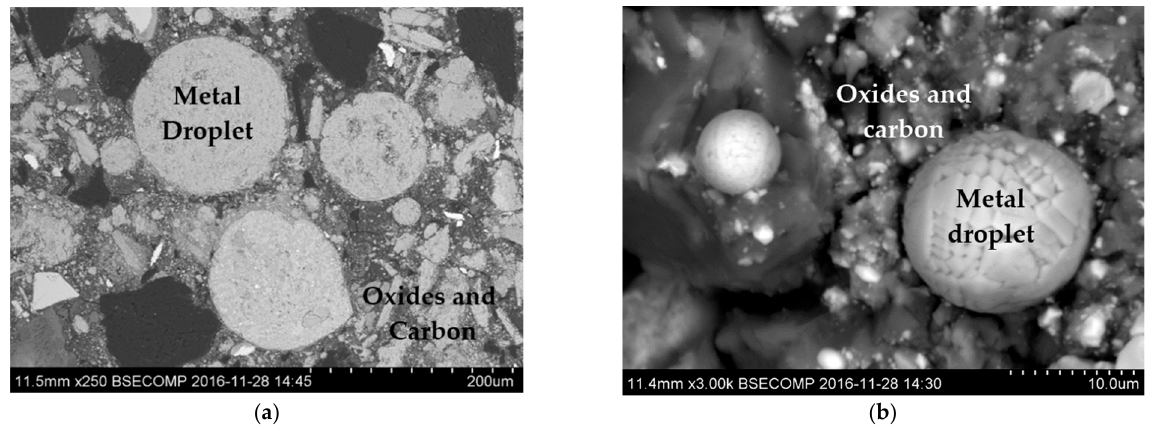
Figure 4. SEM images of different metal droplets ( a ) and ( b ) observed in the slag after completion of the TGR experiments.